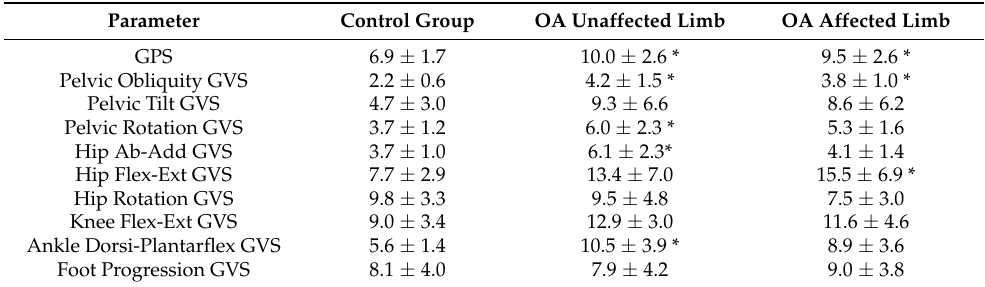
Table 3. GPS and GVS indexes (in degrees). Values are expressed as mean ± SD.